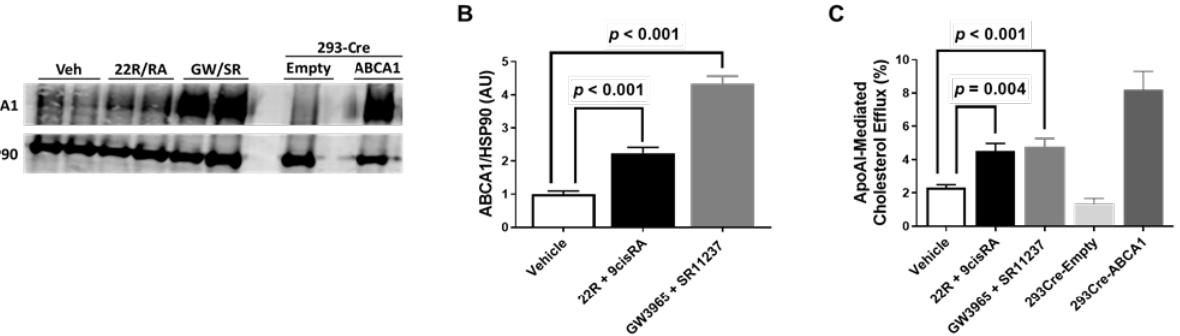
Figure 3. Effect of combining LXR and RXR agonist treatments on ABCA1 protein expression and apoAI-mediated cholesterol efflux in immortalized mouse aortic endothelial cells (iMAEC). ( A ) iMAEC were cultured in basal conditions and treated with either vehicle only (Veh), 22(R)-hydroxycholesterol and 9-cis-retinoic acid (22R/RA), or GW3965 and SR11237 (GW/SR). 293-Cre cells were transfected with either empty vector plasmid (technical negative control) or ABCA1-expressing plasmid (technical positive control). ABCA1 protein from cell lysates were assessed via immunoblotting. HSP90 is the housekeeping protein. ( B ) Quantification of ABCA1 in representative immunoblot ( A ) and two other immunoblots for iMAEC (three independent treatments; each with two biological replicates per respective treatment). AU, arbitrary units; data are mean ± SEM. ( C ) ApoAI-mediated cholesterol efflux measured in serum-starved, [ 3 H]cholesterol-loaded iMAEC treated with vehicle only, 22R and 9-cis-retinoic acid, or GW3965 and SR11237. ApoAI-mediated cholesterol efflux was also measured in serum-starved, [ 3 H]cholesterol-loaded 293-Cre cells transfected with empty vector plasmid (technical negative control) or ABCA1-expressing plasmid (technical positive control). Three independent experiments with three biological replicates per treatment for each experiment. Data are mean ± SEM.